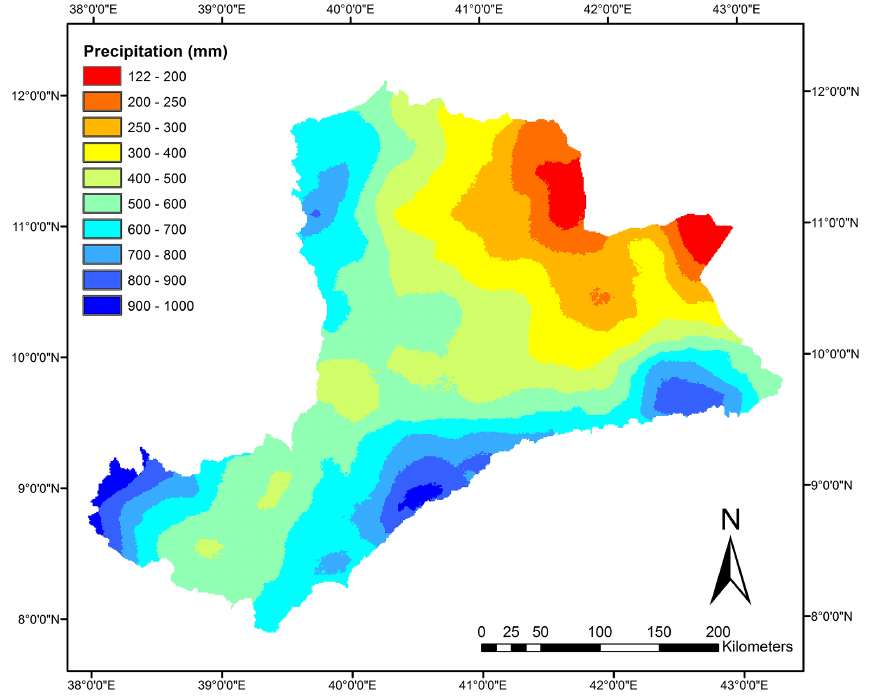
Figure 3. Spatial distribution of annual rainfall of the Awash Basin for the average rainfall year 2009 taken from FEWS Net (after Dost et al.,